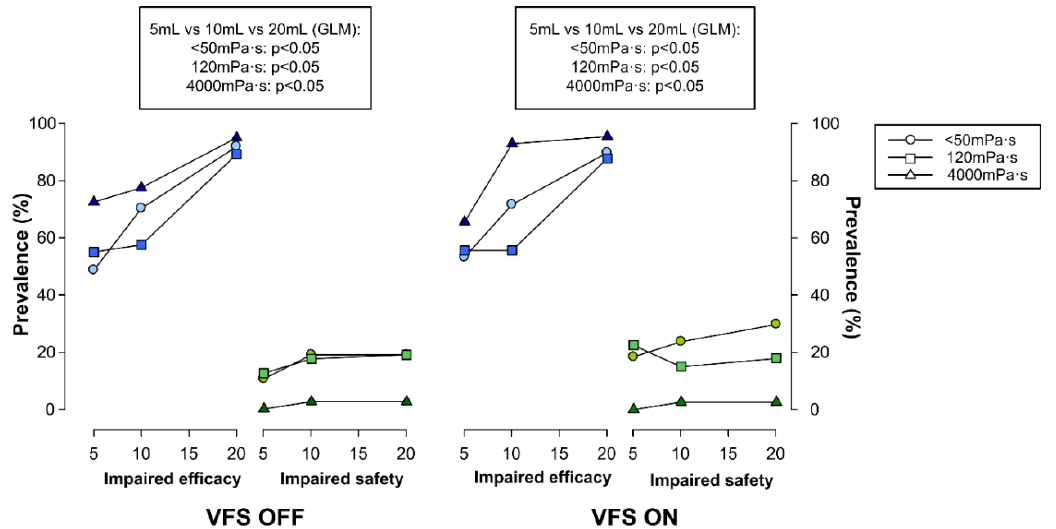
Figure 5. E ff ect of increasing bolus volume on prevalence of impaired swallow safety and e ffi cacy for Figure 5. Effect of increasing bolus volume on prevalence of impaired swallow safety and efficacy for three bolus viscosities ( < 50 mPa · s, 120 mPa · s, and 4000 mPa · s) evaluated using videofluoroscopy three bolus viscosities (<50 mPa·s, 120 mPa·s, and 4000 mPa·s) evaluated using videofluoroscopy (VFS).